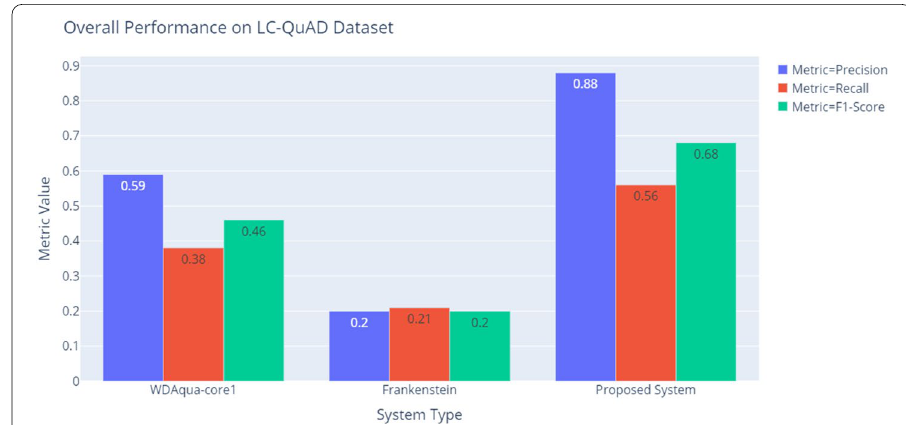
Fig. 5 End-to-end performance on the LC-QuAD dataset